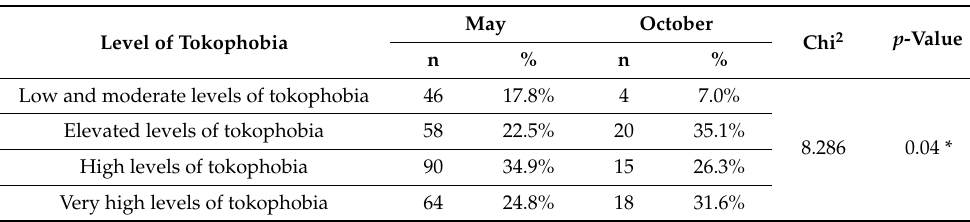
Table 7. The influence of the time during the wave of the pandemic and the severity of tokophobia (n = 315).